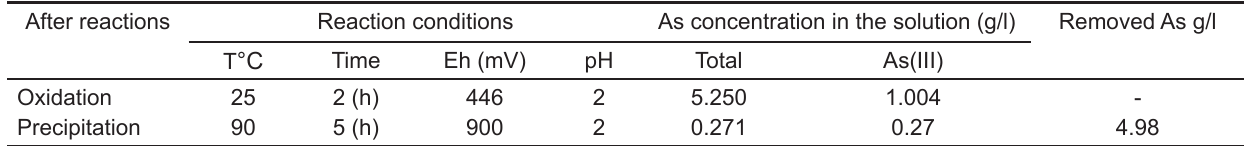
Table 2. Oxidation and precipitation of As